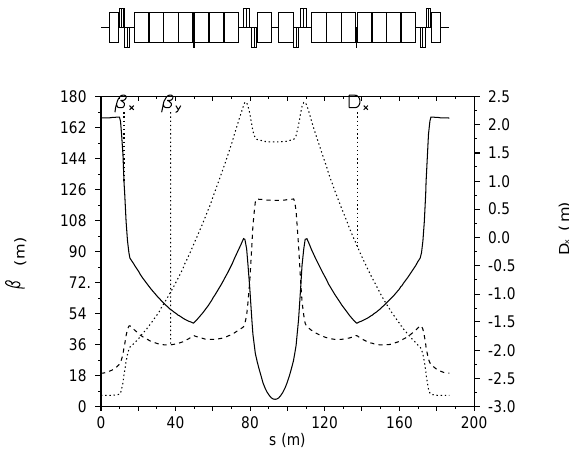
FIG. 42. Example (a): 3 TeV arc